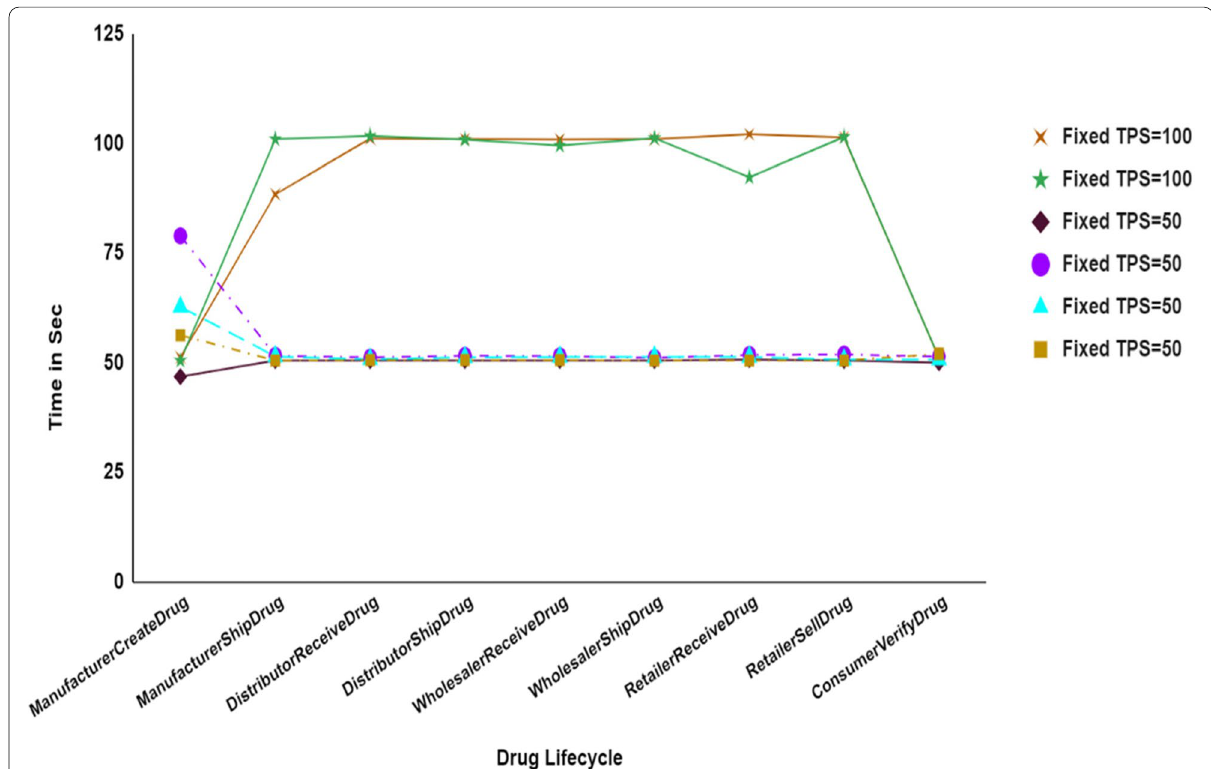
Fig. 9 Comparative Analysis of Response Time with Different Fixed Transaction